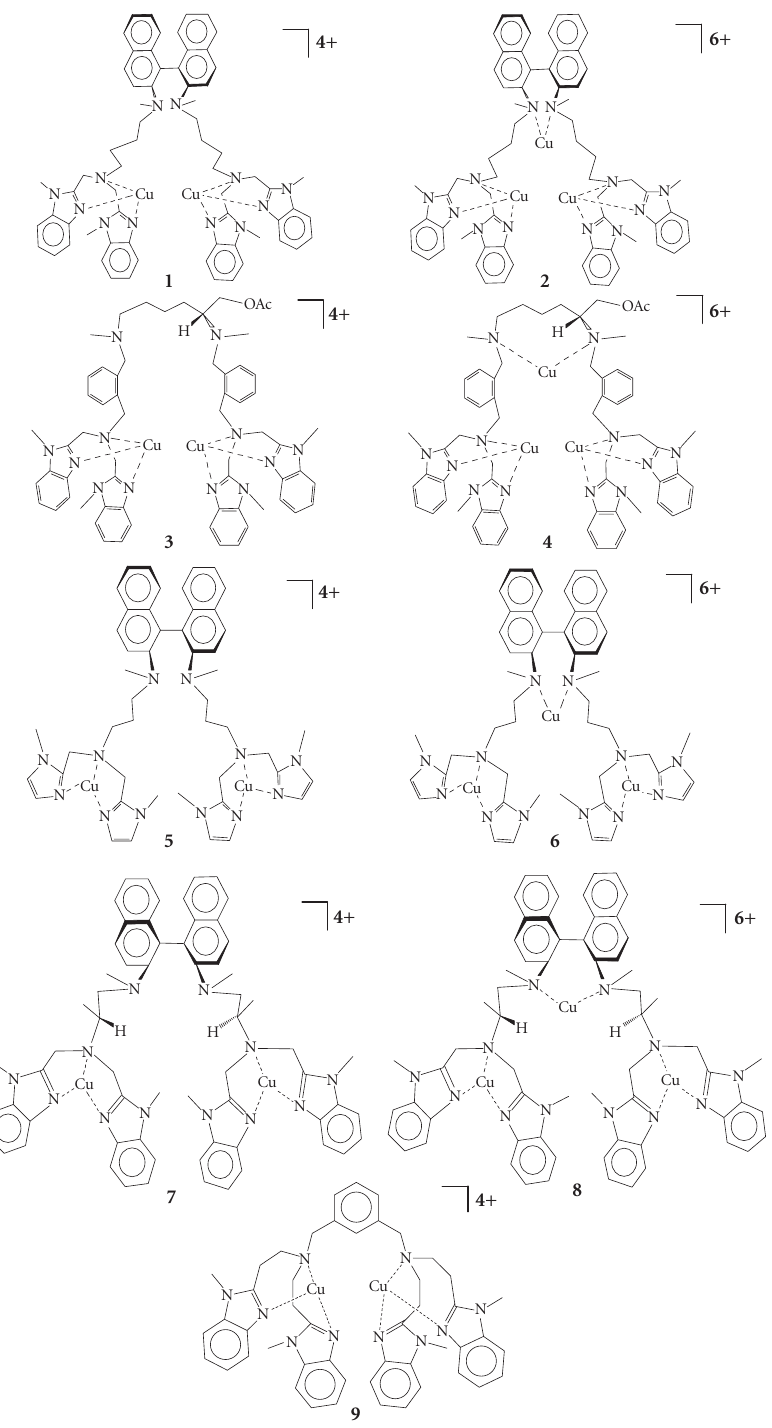
Figure 1: Dinuclear and trinuclear copper complexes used in the biomimetic catalytic oxidations of catechins.